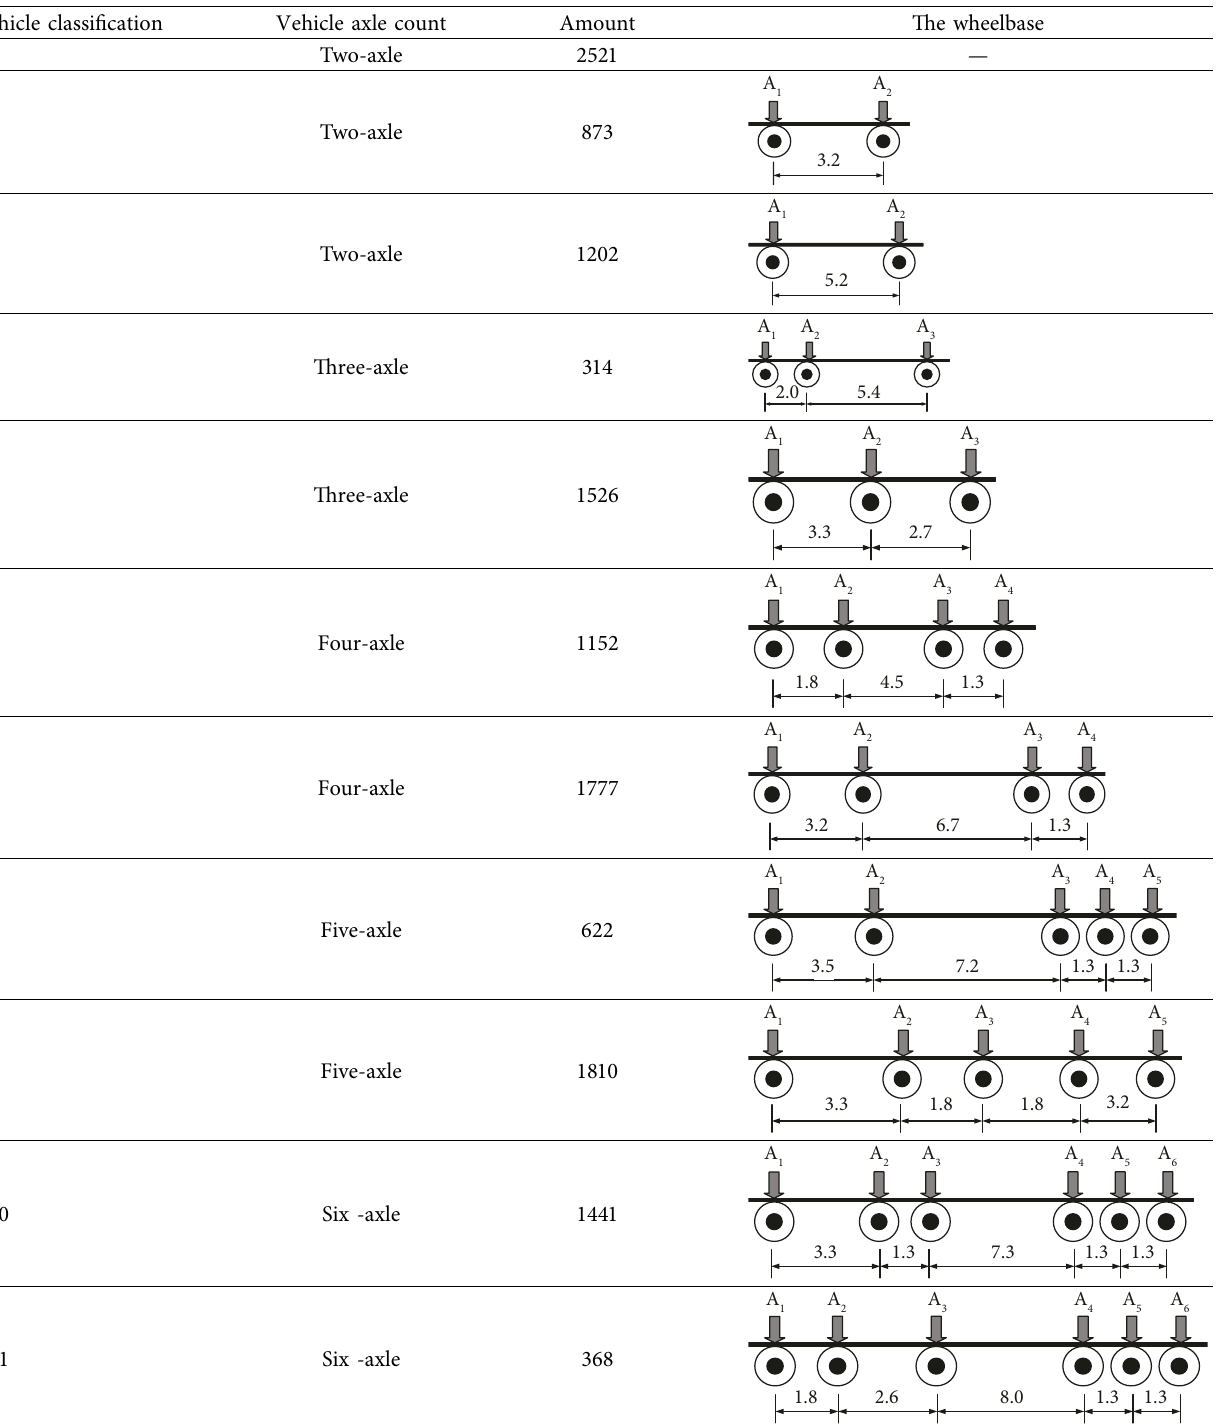
Table 2: Vehicle